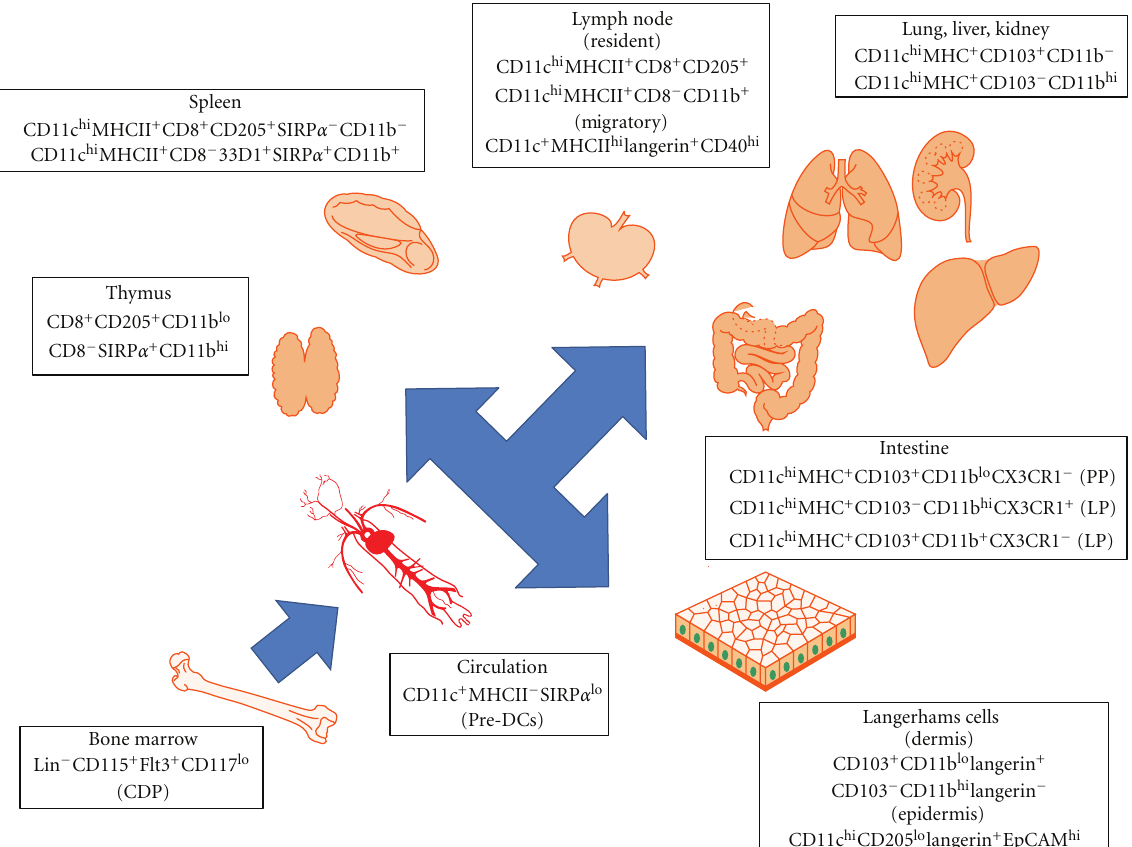
Figure 1: Conventional murine DCs in the steady state. Several DC subpopulations have been described in the mouse model colonizing lymphoid organs and other tissues. Figure adapted from Motifolio Biomedical Toolkit